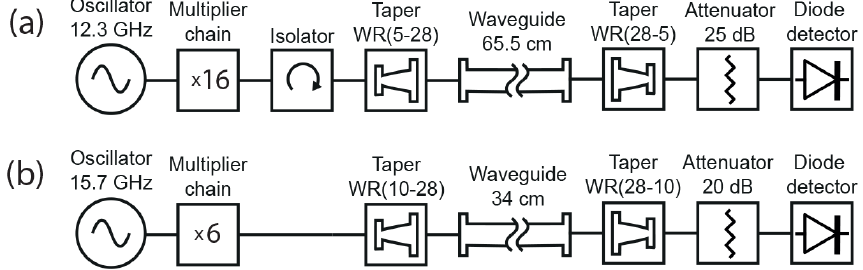
Figure 2. Schematic setup for measuring transmission losses at (a) 197GHz and (b) 94GHz microwave